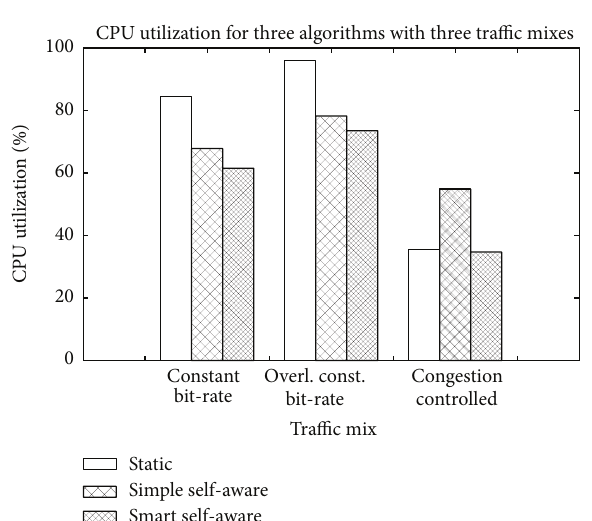
Figure 11: Packet loss for all combinations of mapping algorithms and network traffic